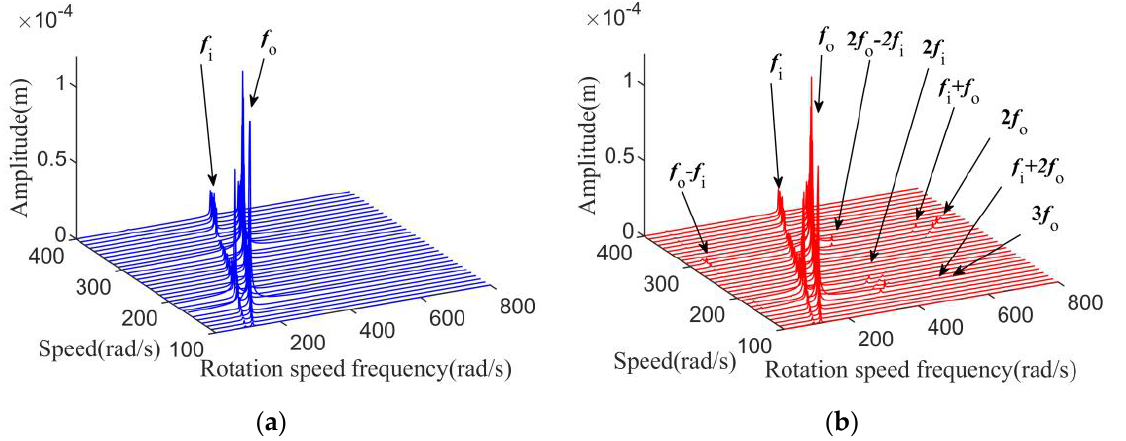
Figure 14. Waterfall plots of frequency responses of the disk 1 under different rotation speeds. ( a ) The conventional MSDS. ( b ) The nonlinear MSDS.